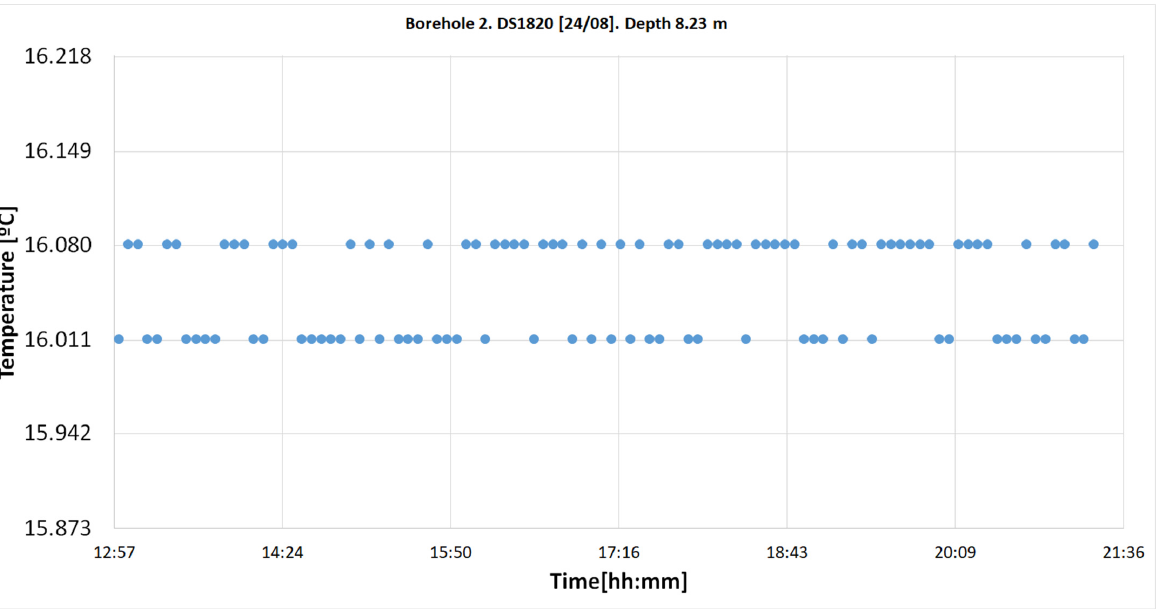
Figure 30 represents the temperature values at 8.23 m, between 12:55 am and 9:21 pm hours. The number of measurements was 103.